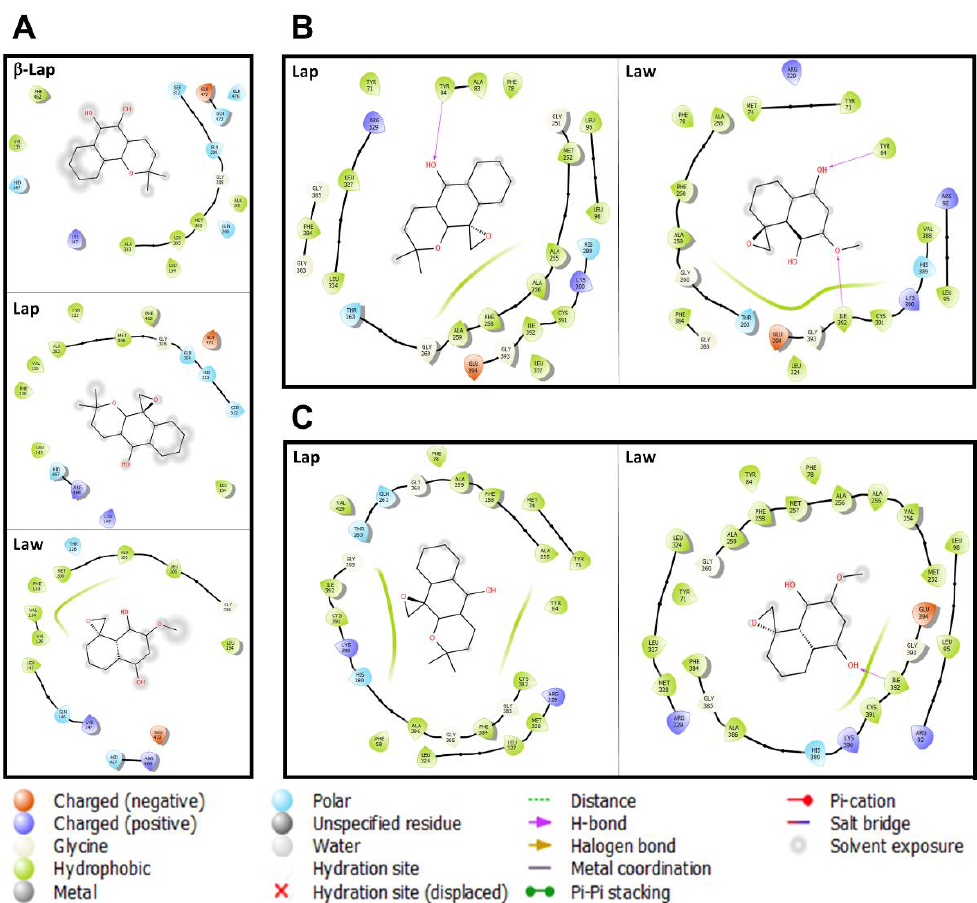
Figure 2. Molecular interaction of naphthoquinone derivatives with Leishmania spp. lanosterol C-14 demethylase . Docking assays were performed with ( A ) Lanosterol C-14 demethylase of Coccidioides posadasii ; ( B ) L. (L.) amazonensis ; ( C ) L. (V.) braziliensis . The 2D representation indicates the types of bonds that occur in Lanosterol C- 14 demethylase with β -lapachone (2H-Naphtho[1,2-b]pyran-5,6-dione,3,4-dihydro-2,2-dimethyl- β -Lap), Epoxy- α -lapachone (2,2-dimethyl-3,4-dihydro- spiro[benzo[g]chromene-10,20-oxiran]-5(2H)-one-Lap), and Epoxymethyl-lawsone (2-Methyl-4H-spiro-[naphthalene- 1,20-oxiran]-4-one-Law).